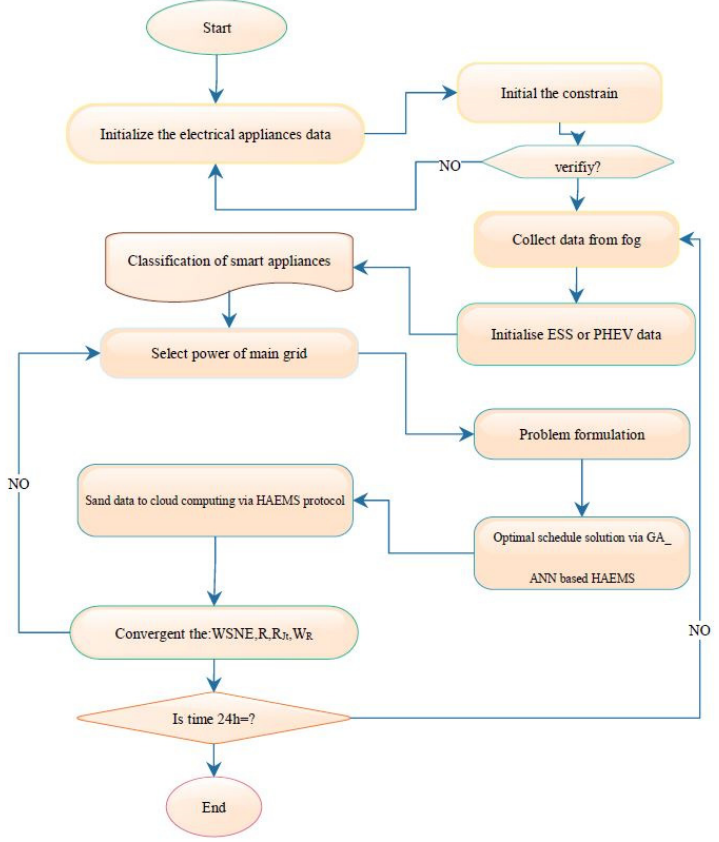
Figure 2. The Proposed protocol flowchart based on cloud computing.